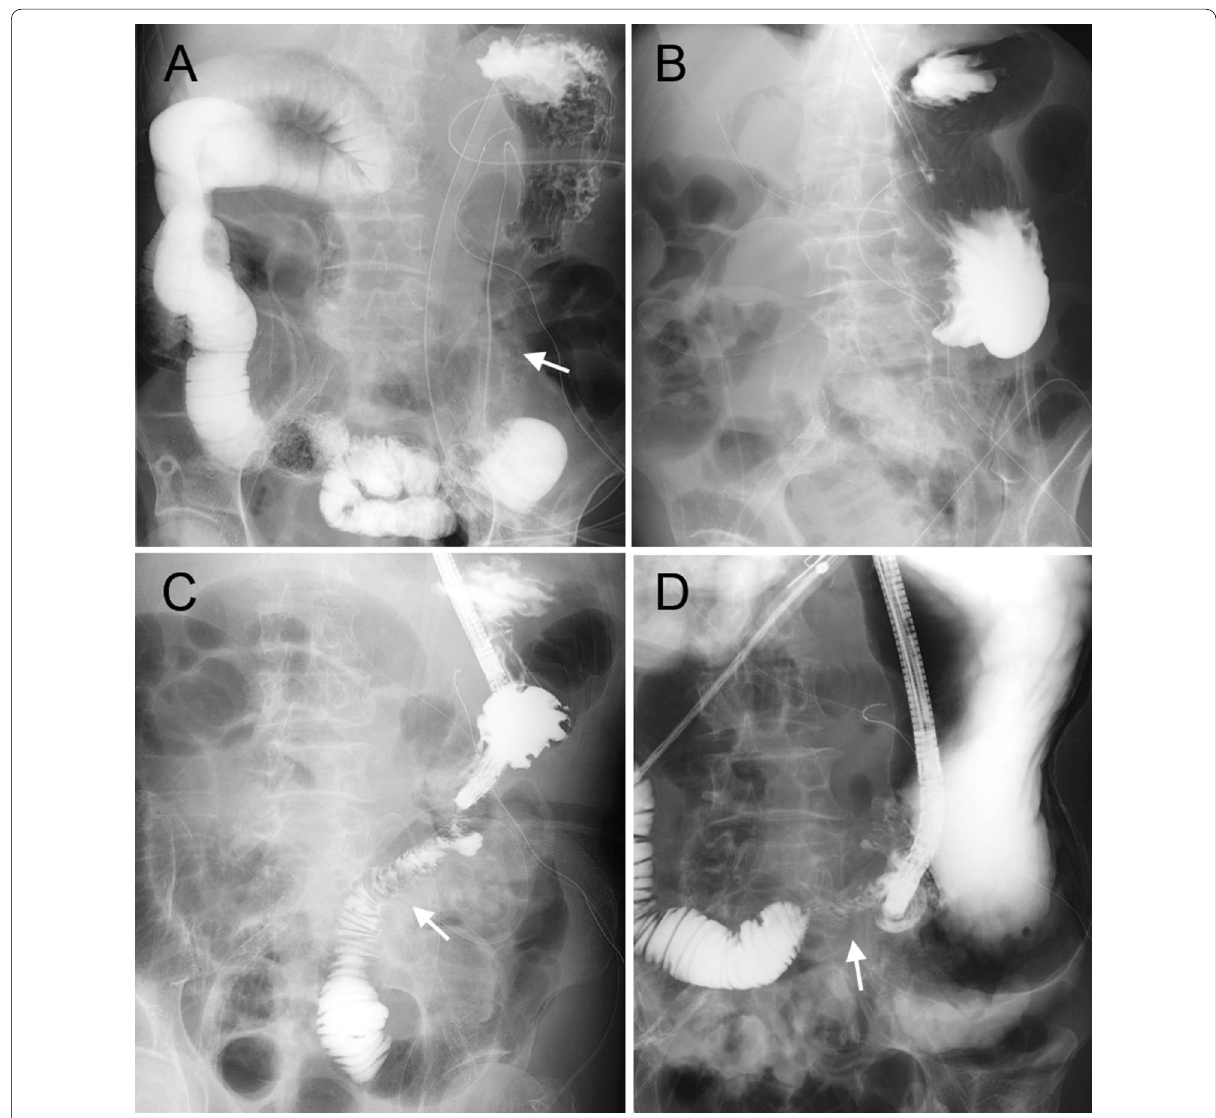
Fig. 3 Findings of upper gastrointestinal series after the initial operation. a A contrast medium easily flowed into the efferent loop (arrow) on postoperative day (POD) 4 . b Contrast medium did not flow into the efferent loop on POD8. c Although upper endoscopy revealed anastomotic edema and stricture, contrast medium flowed into the efferent loop (arrow) on POD12. d The efferent loop (arrow) was twisted rightward on